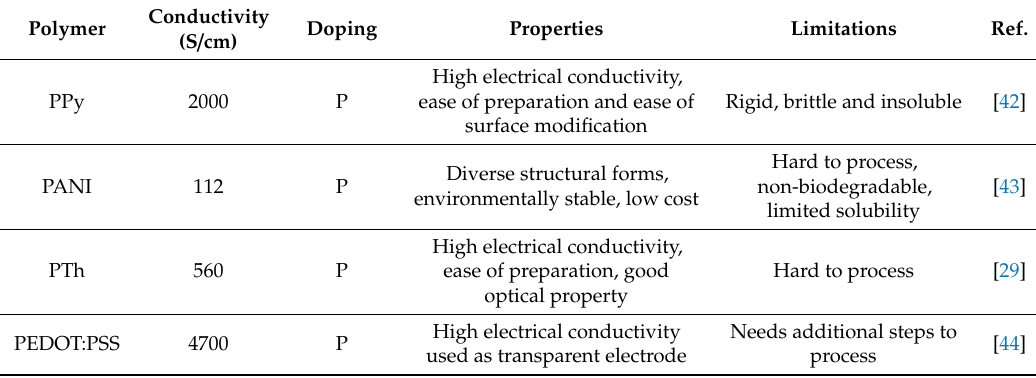
Table 1. Non-exhaustive conductivity and properties of common conductive polymers.